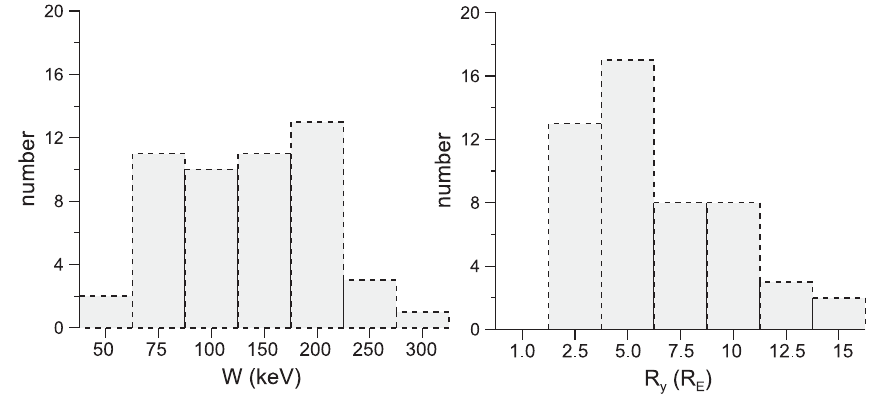
Fig. 5. The distributions of observed values of W and estimates of R y